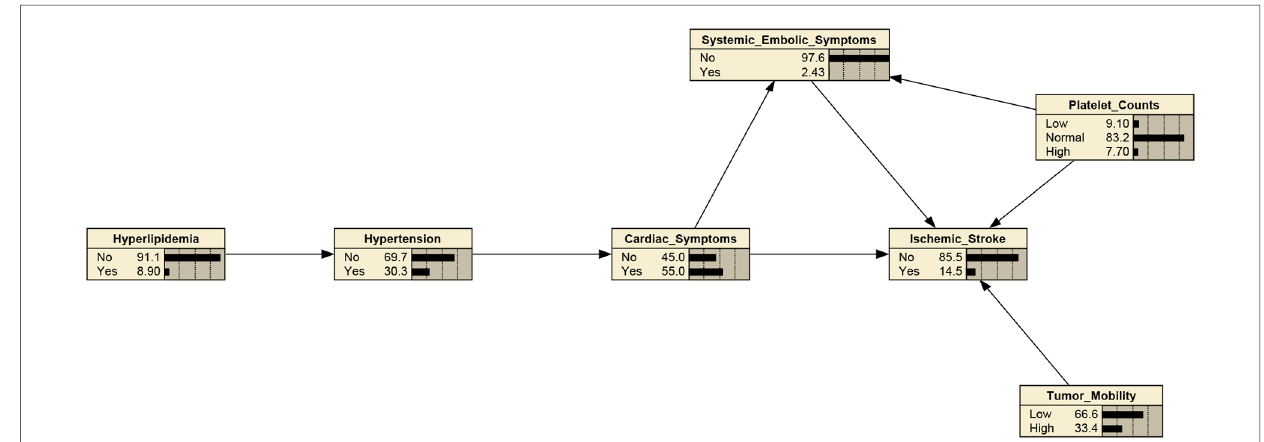
FIGURE 2 Bayesian network (BN) for predicting occurrence of IS in patients with cardiac myxoma (CM). The Bayesian network used 6 variables selected by mutivariate binary logistic